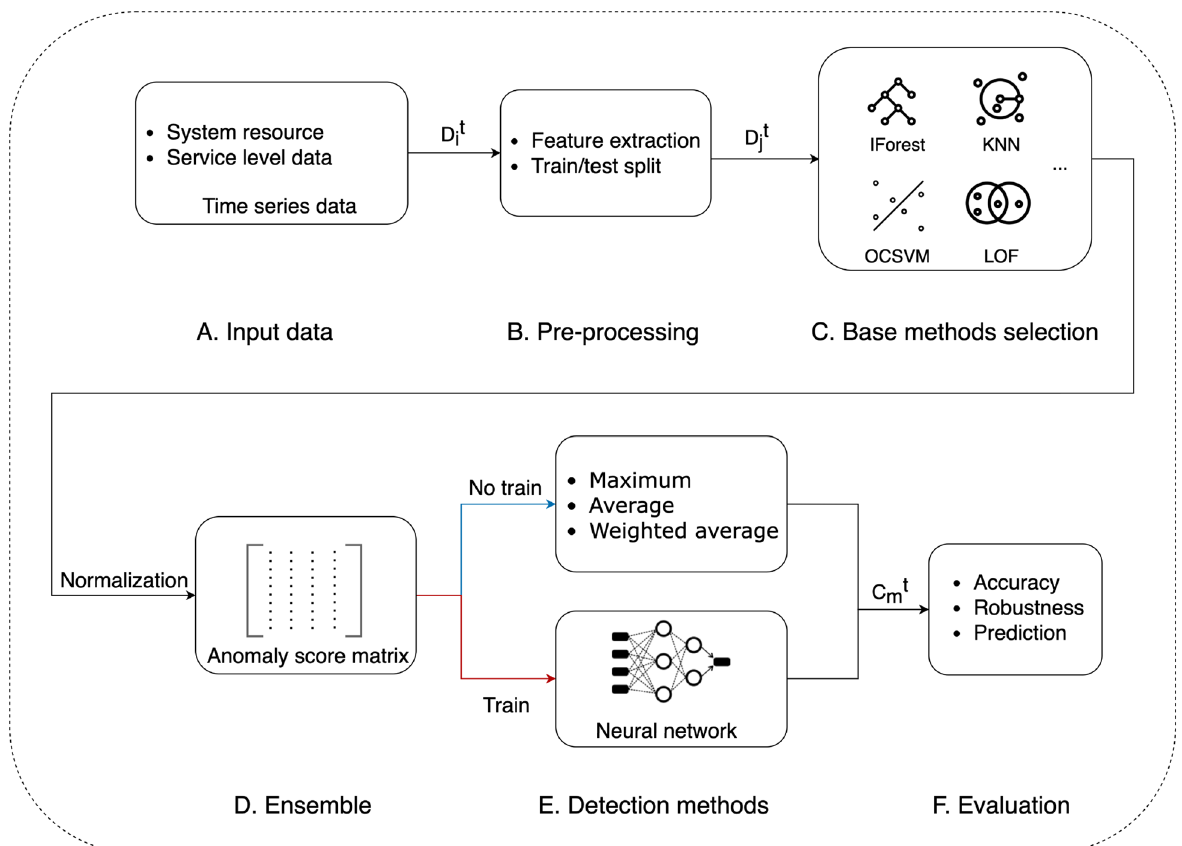
Fig. 2 ELBD framework, including three classic ensemble methods without training (blue line) and a deep ensemble method which need to train a neural network (red